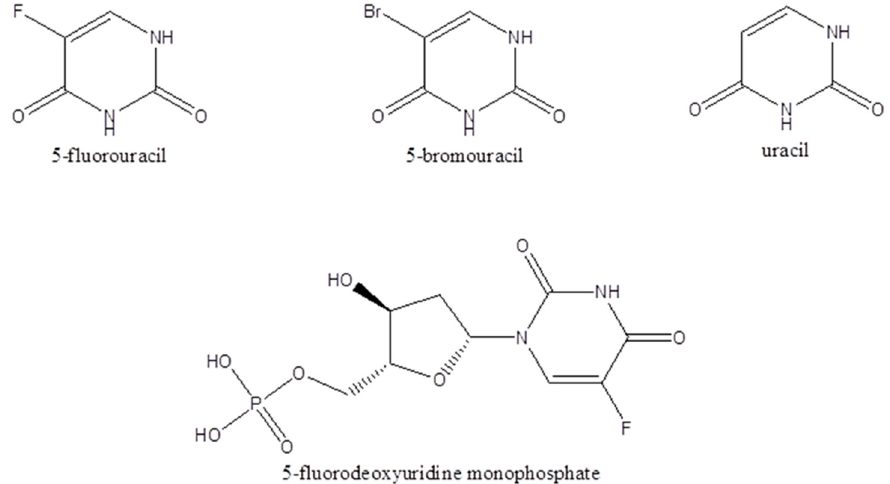
Figure 1. The chemical structures of 5-fluorouracil, 5-bromouracil, uracil, and 5-fluorodeoxyuridine monophosphate.